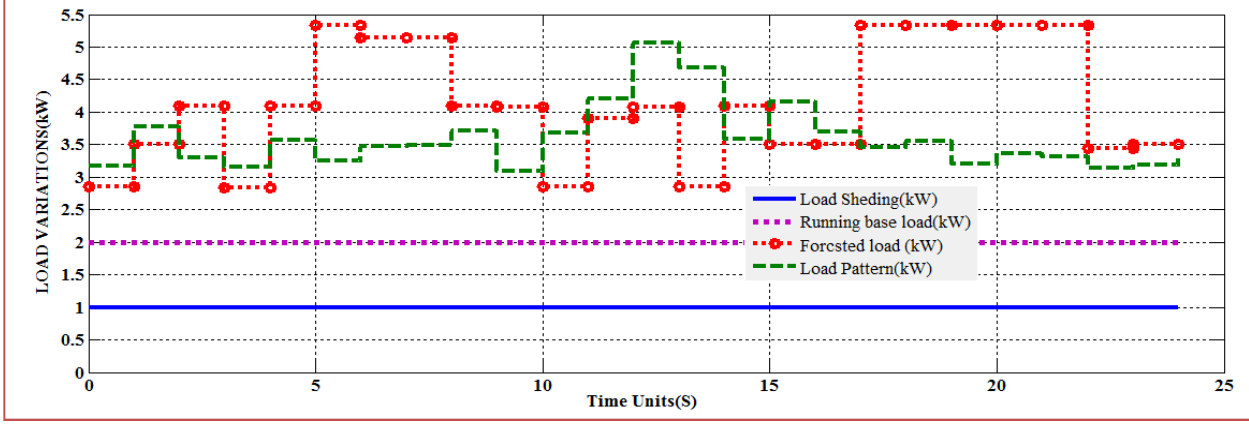
Figure 8. Fuzzy forecasting system output in Simulink .